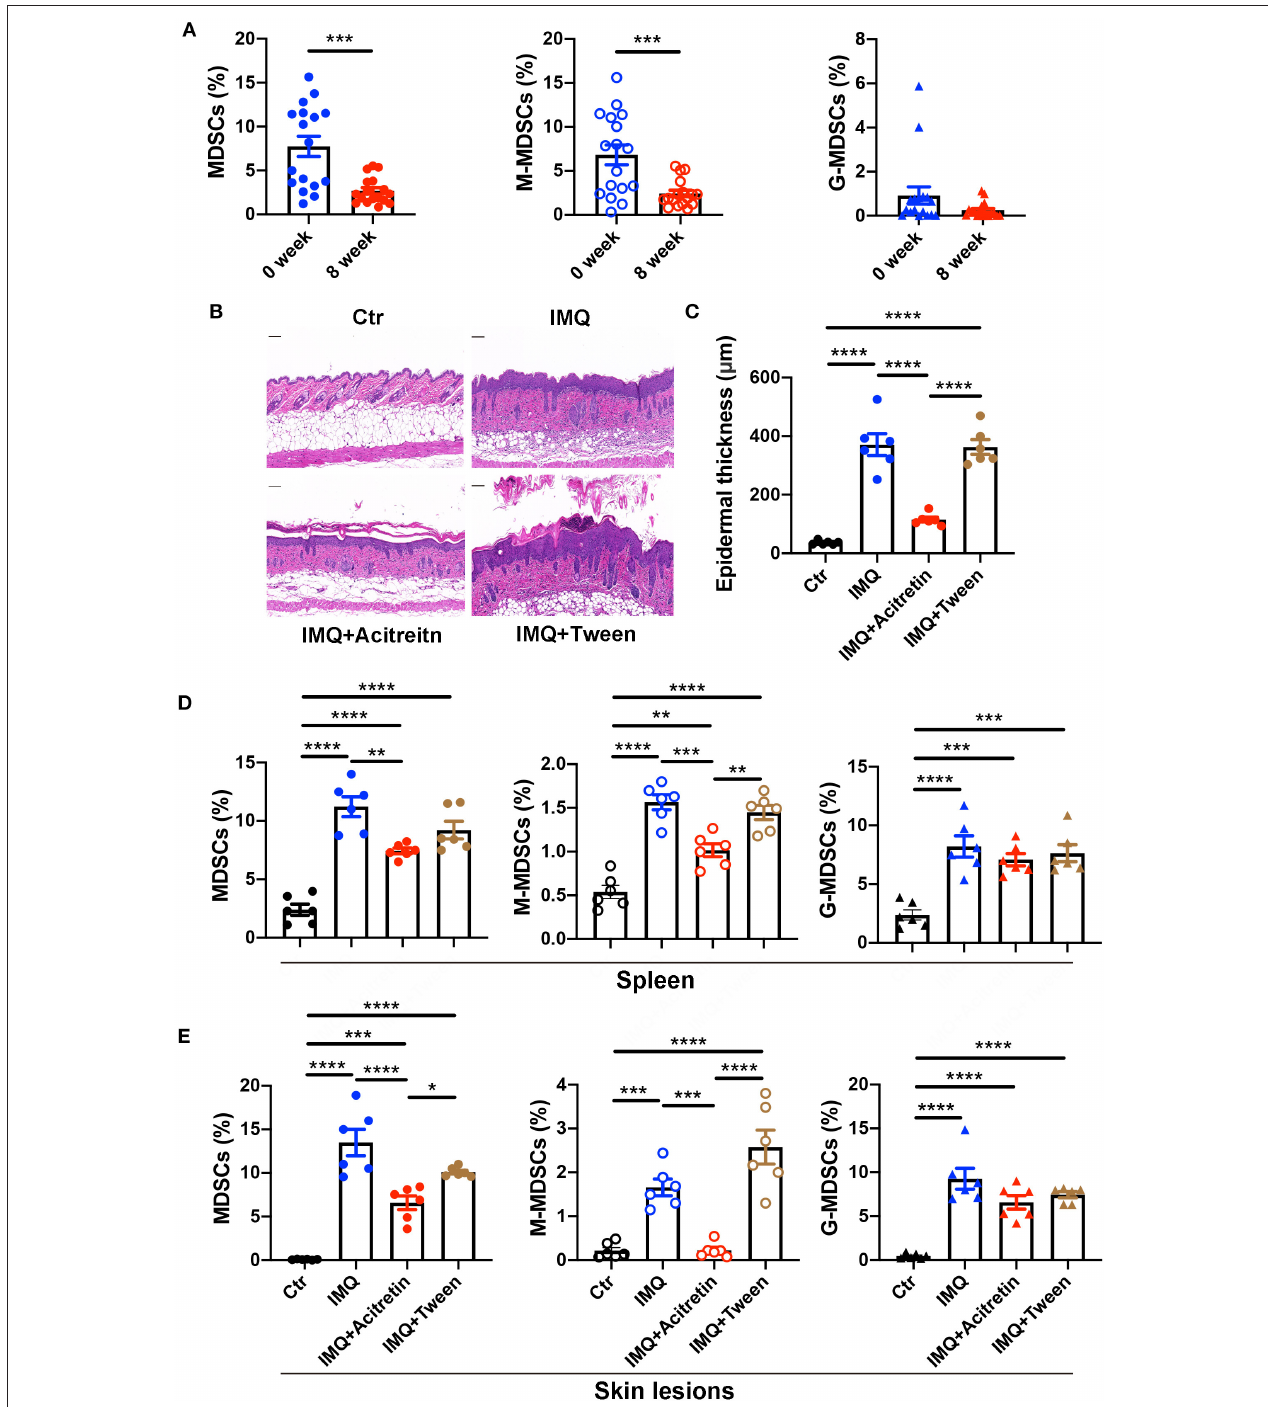
FIGURE 2 | Acitretin deceased the number of MDSCs and M-MDSC in vivo . (A) The percentages of MDSCs (left panel), M-MDSCs (middle panel), and G-MDSCs (right panel) in PBMCs of psoriasis patients before and after the treatment of acitretin for 8 weeks ( n = 17). IMQ-induced psoriasis-like model mice treated with oral acitretin or tween (solvent) once per day for 6 days. (B) The H&E staining of the back skin derived from Control (Ctr) and IMQ-induced model mice treated with acitretin or tween (solvent) ( n = 6). Scale bars: 100 µ m. (C) The epidermal thickness of mice in B ( n = 6). (D,E) The statistical data of Gr-1 + CD11b + MDSCs (left panel), CD11b + Ly6G − Ly6C + M-MDSCs (middle panel), and CD11b + Ly6G + Ly6C − G-MDSCs (right panel) in the spleen (D) and skin lesions (E) of IMQ-induced psoriasis-like model mice treated with oral acitretin or tween (solvent) ( n = 6). All results represent at least 3 independent experiments. Data represent the mean ± SEM. * p < 0.05, ** p < 0.01, *** p < 0.001, **** p < 0.0001.